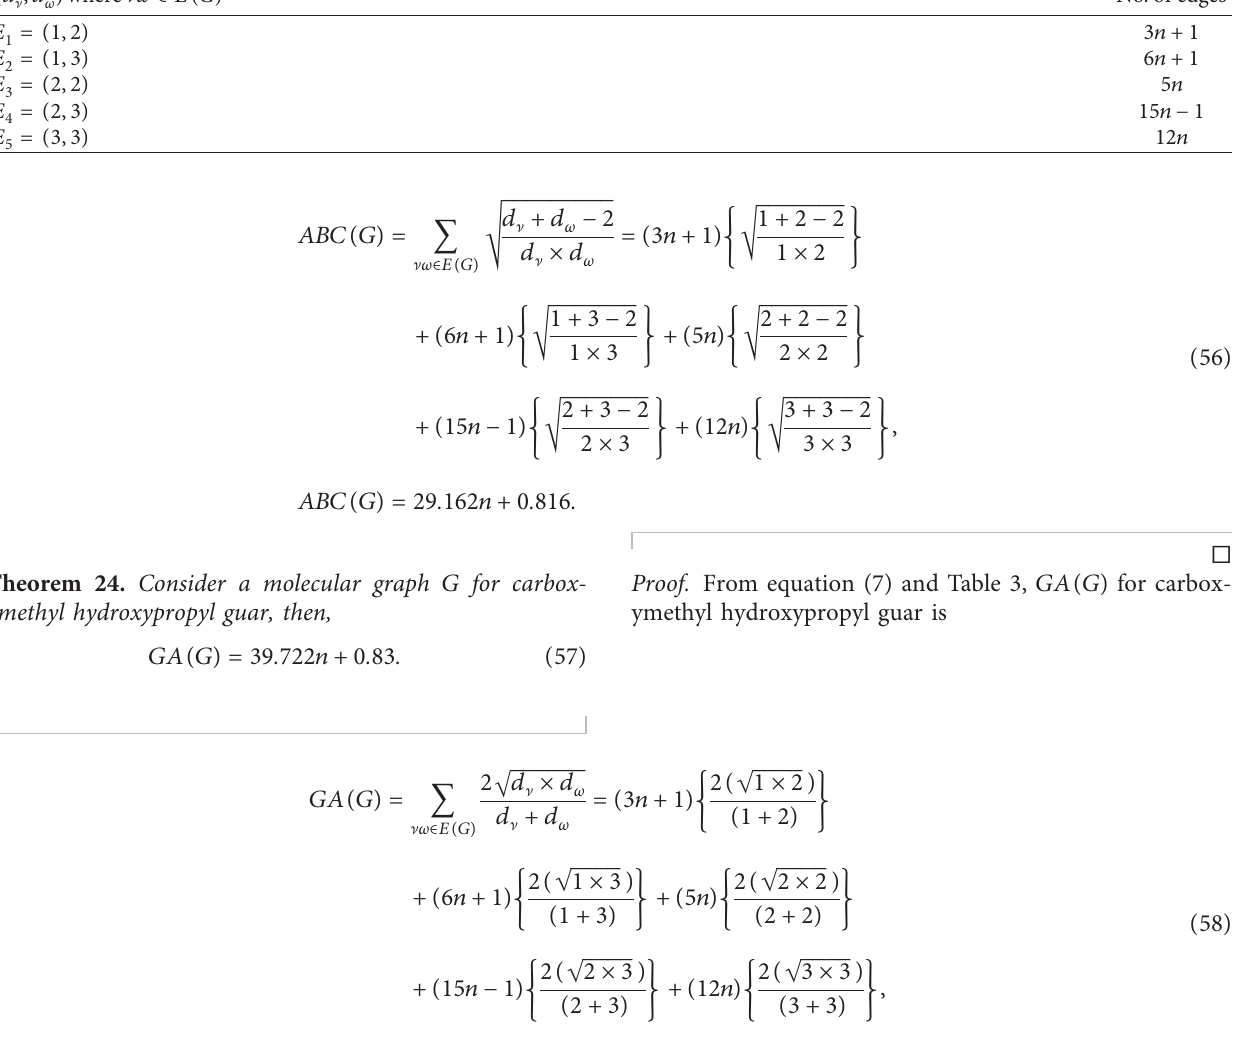
Table 3: The edge partition of the molecular graph of carboxymethyl hydroxypropyl guar based on degrees of the end vertices of each edge. ( d , d ) where ] ω ∈ E ( G ] ω